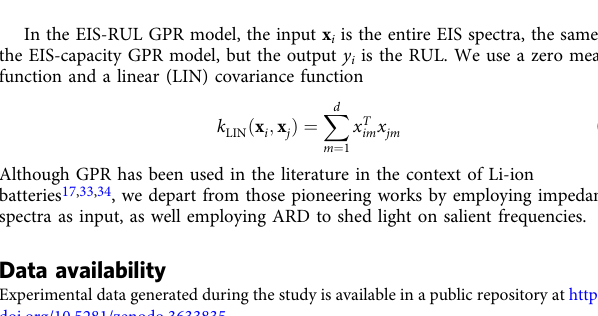
Fig. 4 Remaining useful life prediction without de fi nite knowledge of the temperature. Our model accurately predicts the RUL of three testing cells a – c cycled at 25, 35 and 45 °C, respectively, without information on the cycling temperature. The EoL of these three testing cells is 150, 252 and 396, respectively, which is de fi ned as the cycle number when the capacity reaches its initial 80%. The testing EIS spectra are collected at state V (15 min resting after fully charging). The shaded region indicates ±1 standard deviation. R 2 of our method is shown on the right bottom in